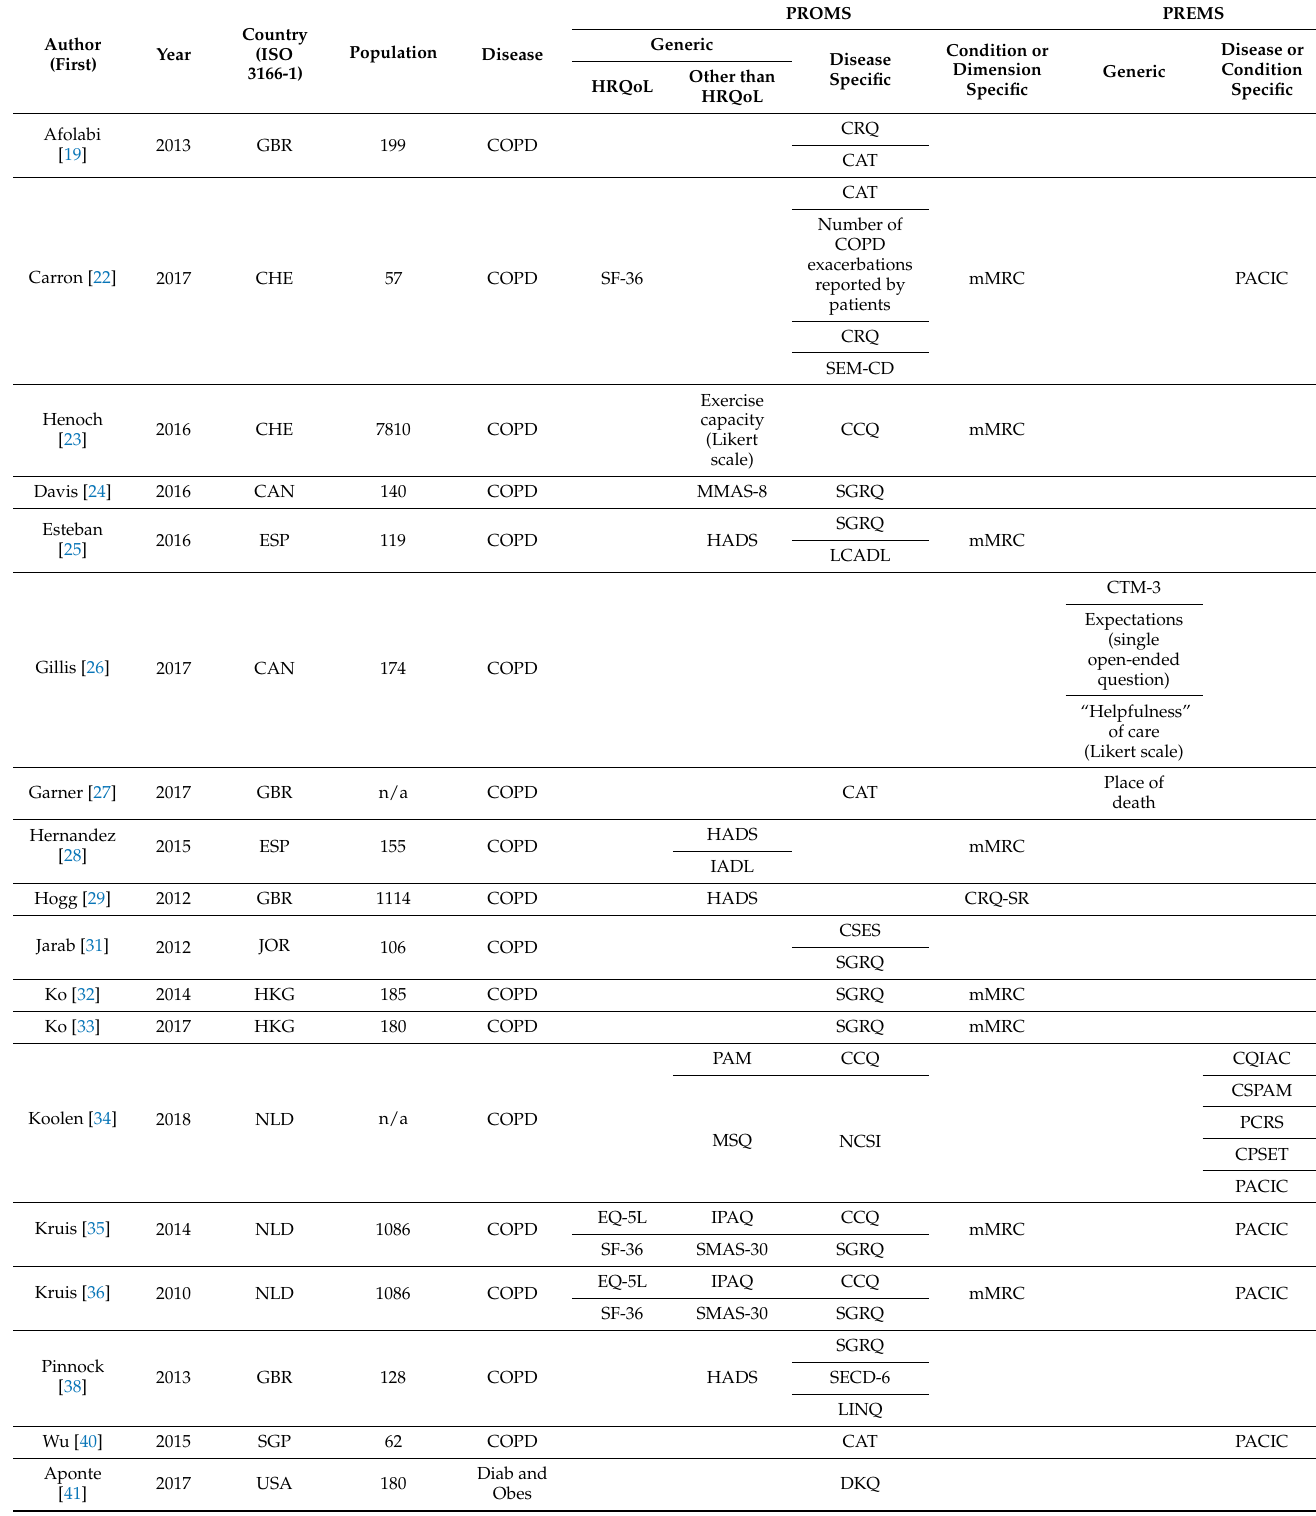
Table 3. Main characteristics reporting PROMs and PREMs in evaluation of integrated